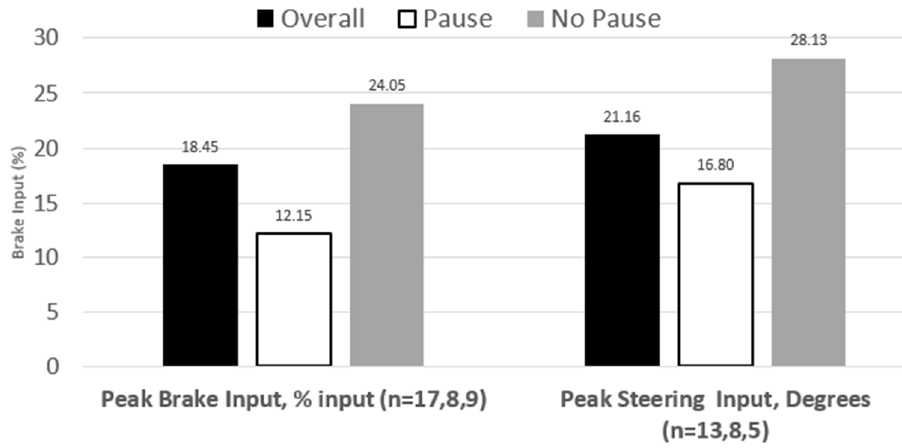
Figure 9. Mean driver response magnitudes: peak brake and steering inputs. Peak brake (pedal percentage input) and steering (degrees) input.